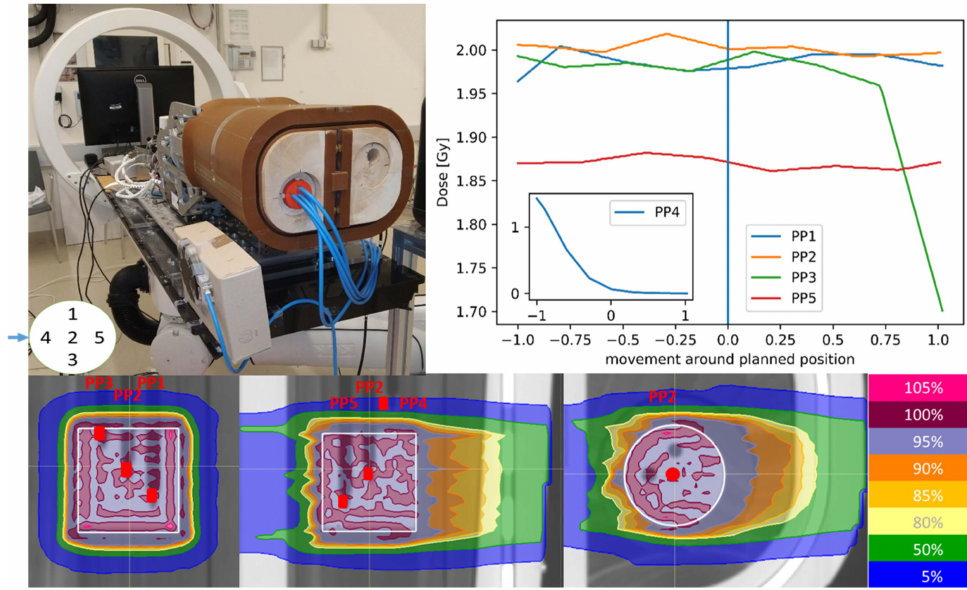
Figure 1. Setup with ARDOS ( left ) and line dose from the carbon ion plan through the PinPoint chambers around the planned position ( right ) with dose profiles from the carbon ion plan ( below ). The red dots show the location of the different PinPoint